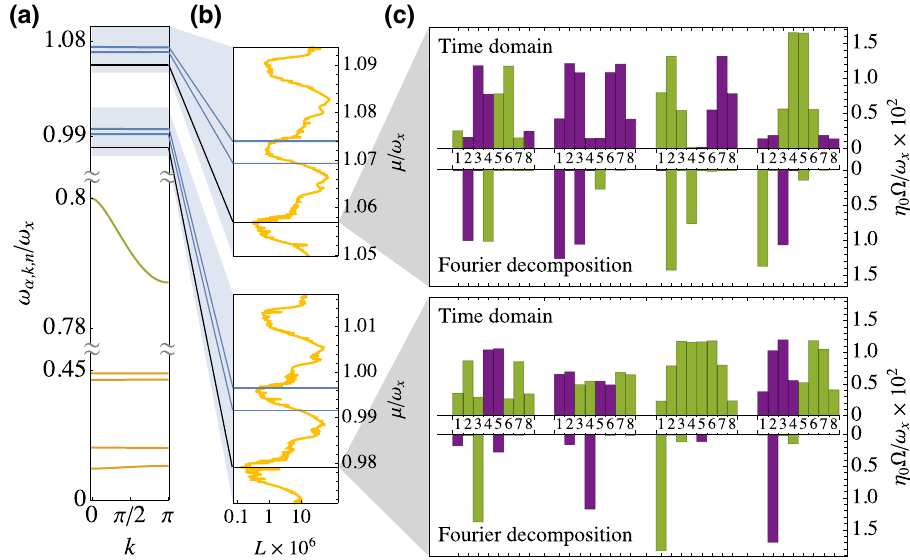
FIG. 9. Pulse optimization in an infinite chain. (a) Phonon-mode spectrum for p = 4, ν 0 = 0.4, and (cid:14) = 0.07. (b) The minimization of the cost function L is performed independently for pinned and not pinned ions. The upper and lower panels show the cost function for optimal sequences of Rabi frequencies for a range of detunings around the COM and stretch bands of pinned and not pinned ions, respectively. (c) For the optimal detunings we show the corresponding G = 4 independent sequences of S = 8 Rabi frequencies both in the time domain and in discrete Fourier space. Purple and green correspond to positive and negative Rabi frequencies, respectively. The Fourier representations are dominated by few modes, which belong to subspaces of Fourier space that alternate along the chain: a pulse sequence that contains only odd Fourier components is followed by a sequence that is composed of even Fourier components and vice